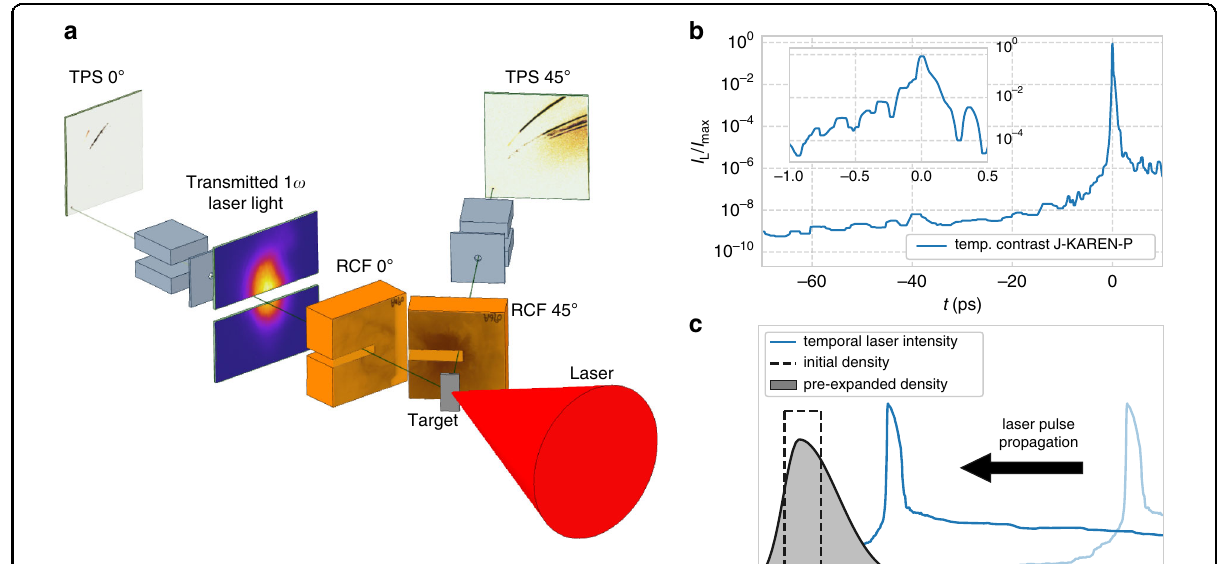
Fig. 1 Sketch of the experiment. a The J-KAREN-P laser was focused onto Formvar fi lms at 45°. Accelerated particles were detected spatially by two radiochromic fi lms (RCF) stacks and spectrally by two Thomson Parabola Spectrometers (TPS) oriented at 0° and 45° with respect to the laser axis. When RCF is not used, a ground glass screen diffusely scattered transmitted laser light for detection by a fi ltered CCD camera. b Temporal intensity contrast of J-KAREN-P on the sub 70 ps and sub 1 ps scale (inset) measured by third-order auto-correlation and spectral interferometry, respectively. c Illustration of prepulse-induced expansion of the target before main pulse